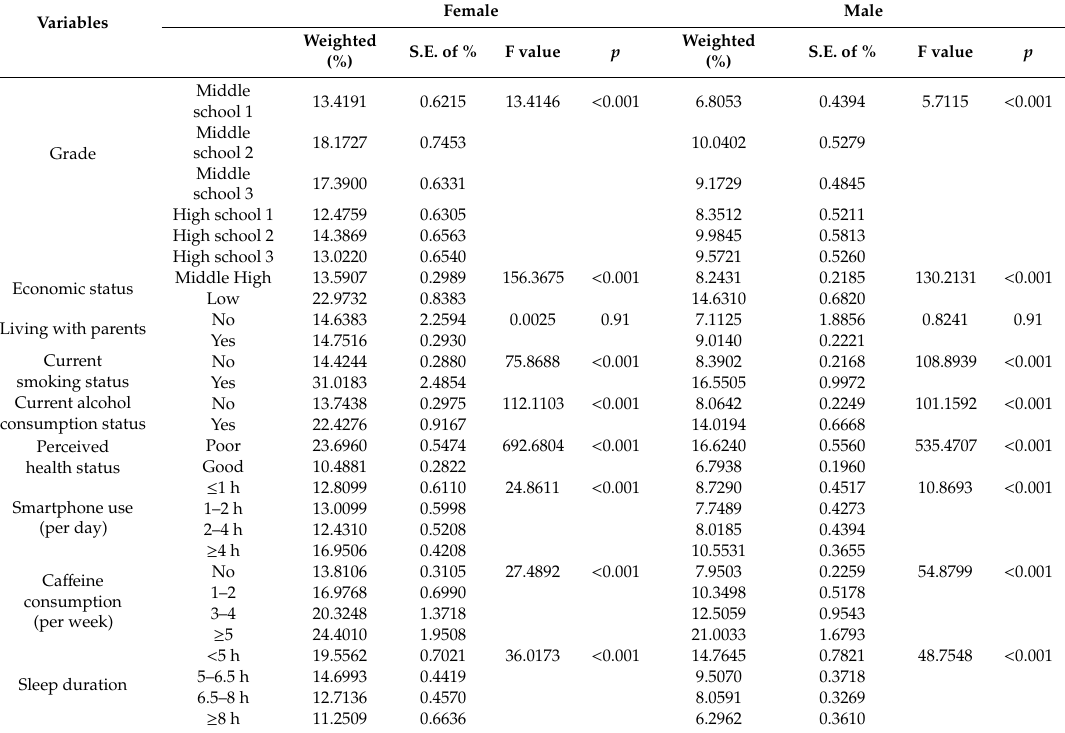
Table 4. Risk factors for suicidal